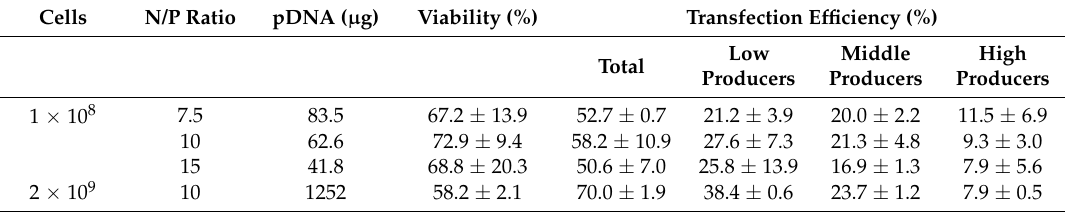
Table 4. Large scale high cell density (HCD) transfection of Jurkat